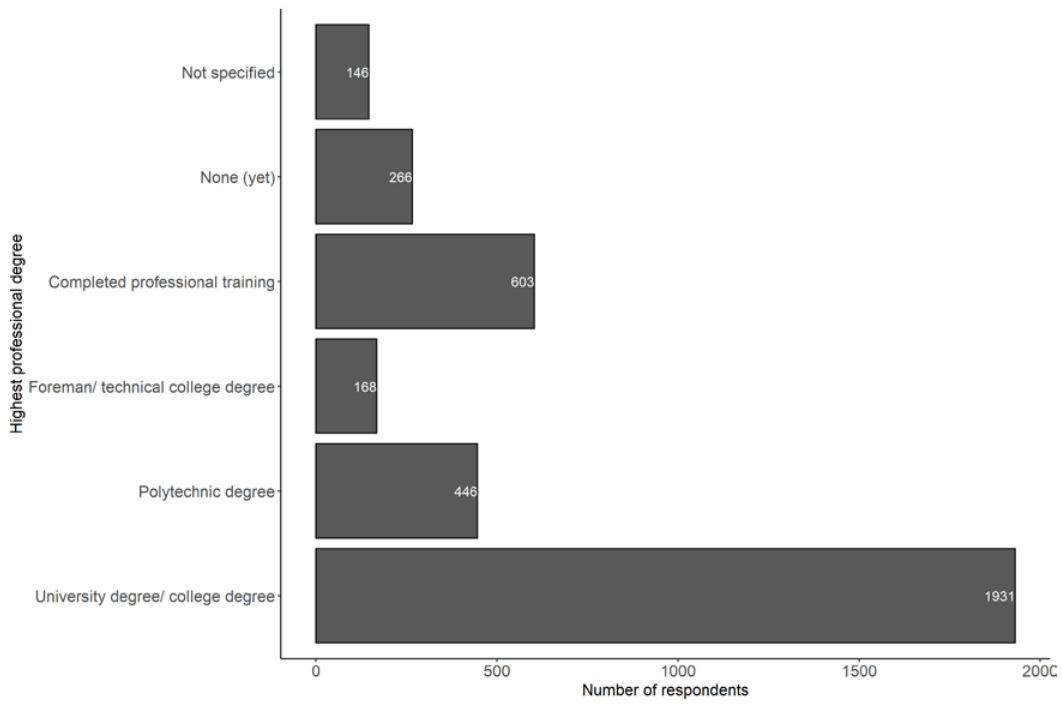
Figure A3.3: Highest professional degree of survey 3,559 respondents